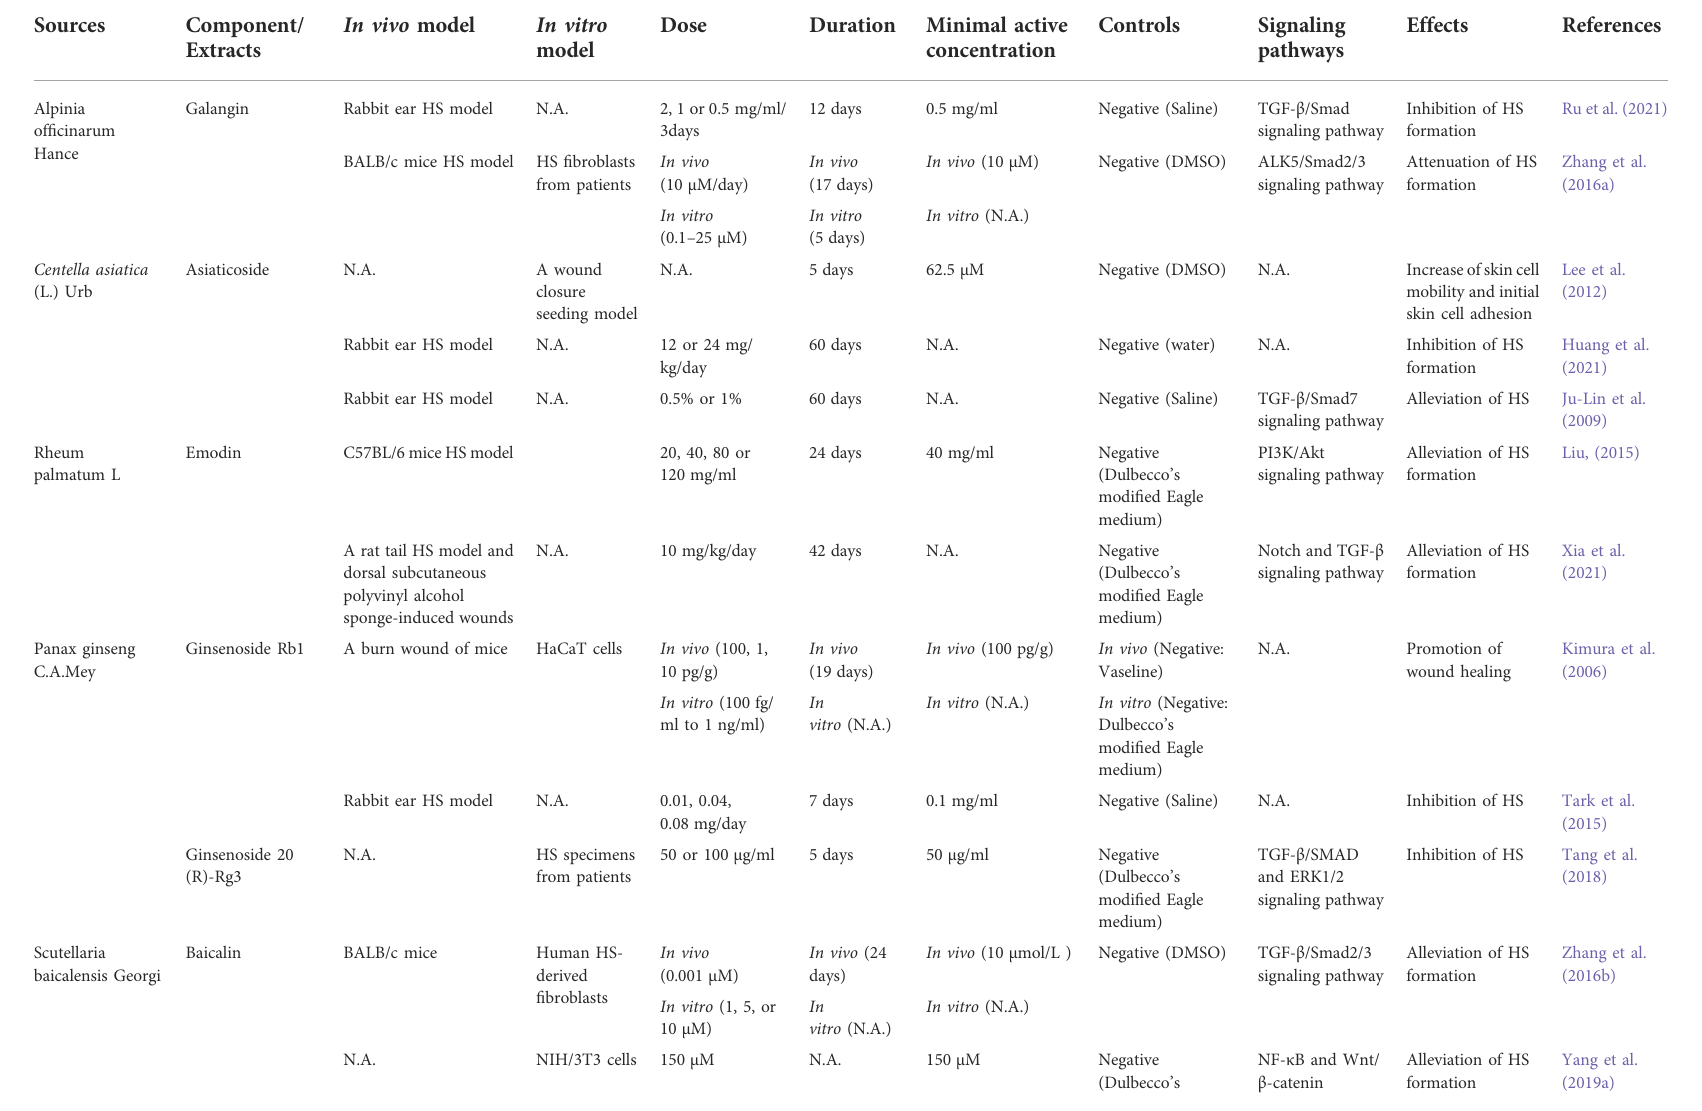
TABLE 2 A summary of the commonly used TCM in the treatment of